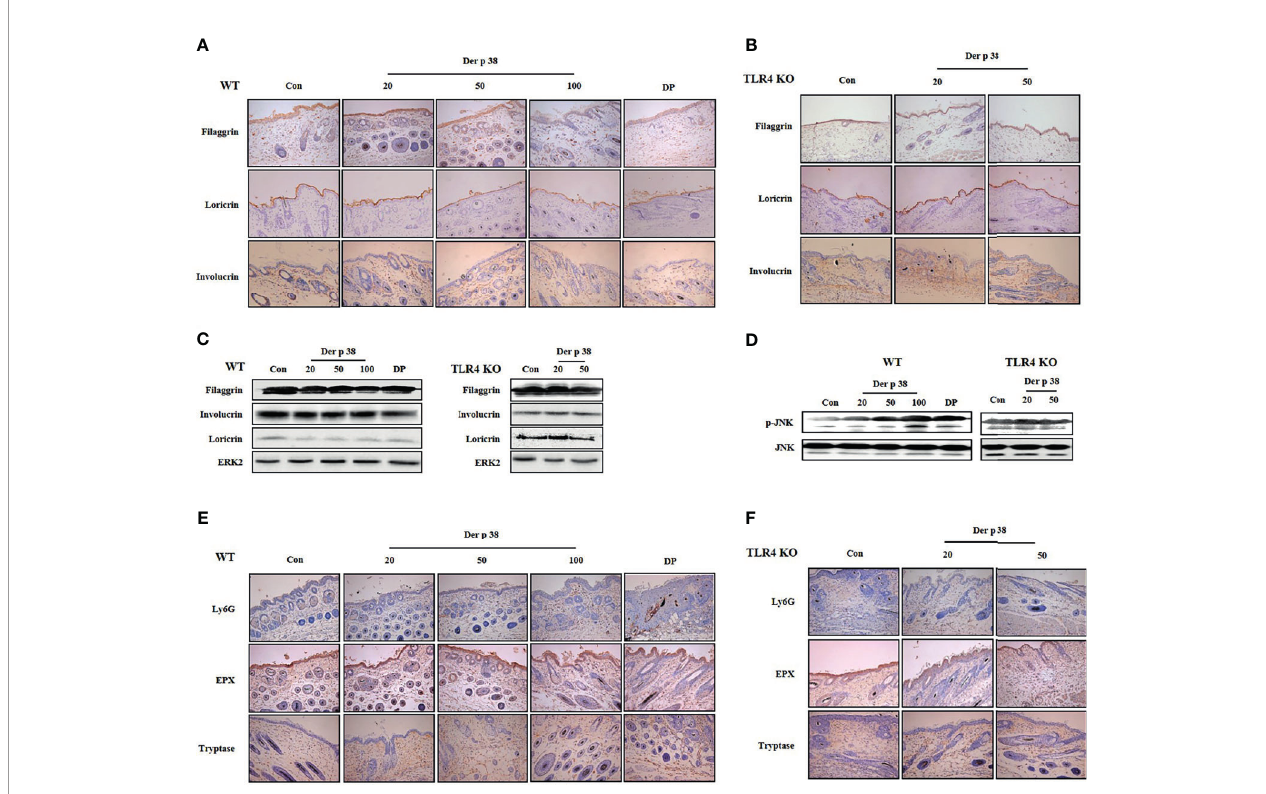
FIGURE 5 | Der p 38 decreases the expression of fi laggrin and increases neutrophils, eosinophils and mast cells in the skin of mice. (A, B, E, F) For skin barrier proteins and in fl ammatory cell analysis, skin sections of wild type (WT) (A, E) and TLR4 KO mice (B, F) were fi xed, embedded in paraf fi n, and incubated with primary antibodies against fi laggrin, loricrin, involucrin, Ly6G, eosinophil peroxidase (EPX) and tryptase. The samples were examined by light microscopy (magni fi cation, ×200). Filaggrin, loricrin, involucrin (C) , and phospho-JNK (D) in tissue lysates were analyzed by Western